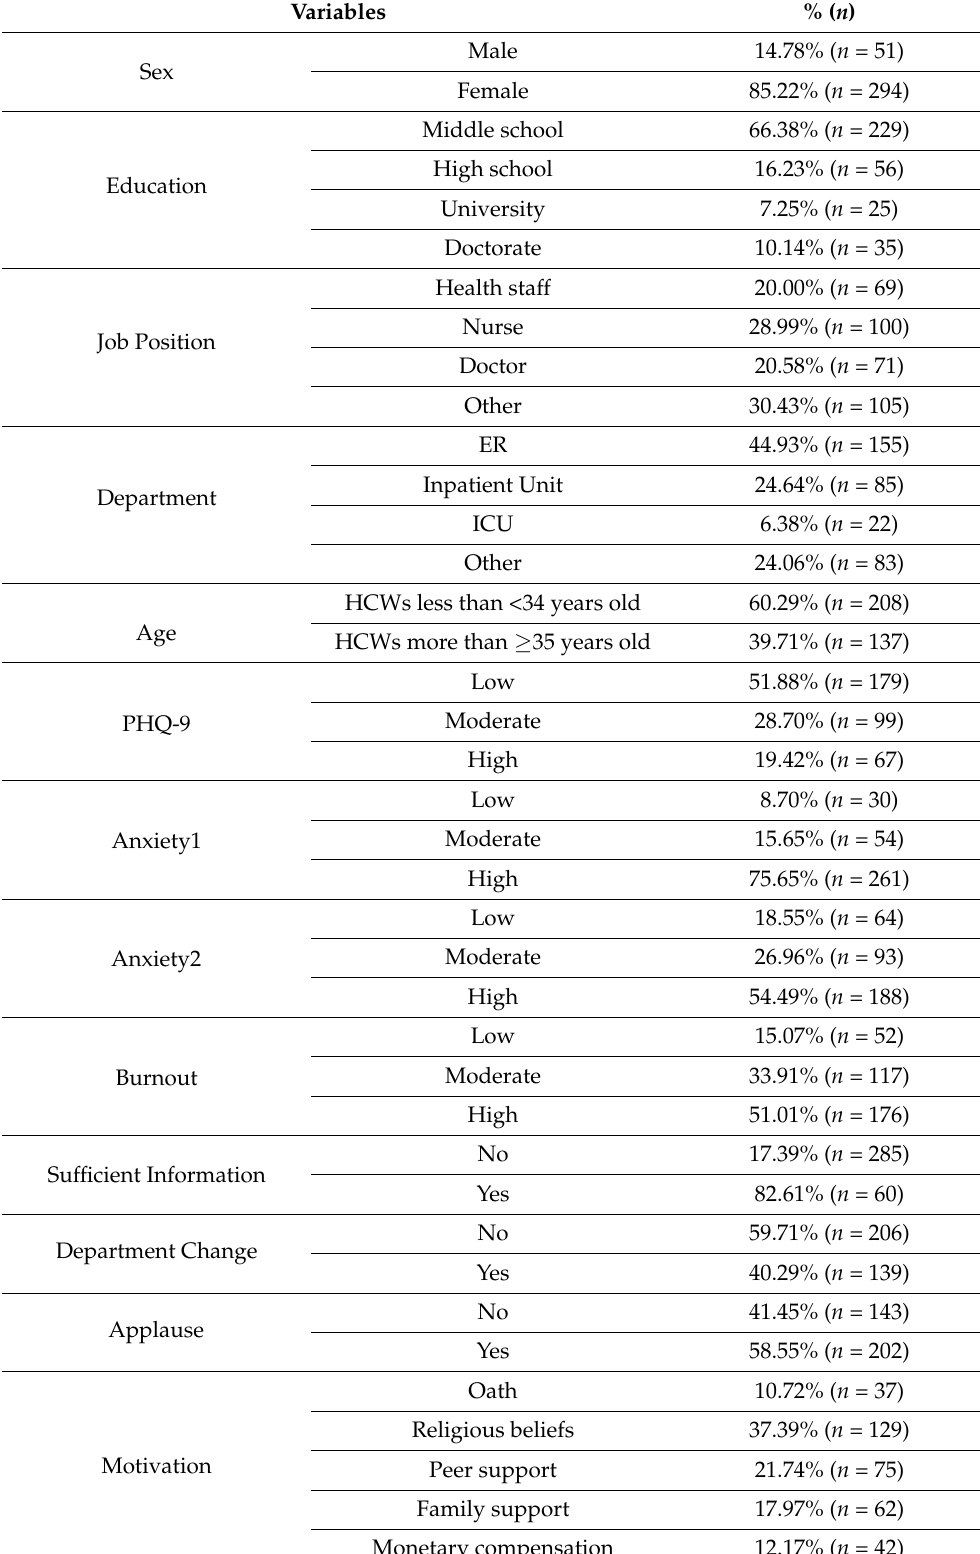
Table 1. Descriptive statistics of the work factors’ distribution of the